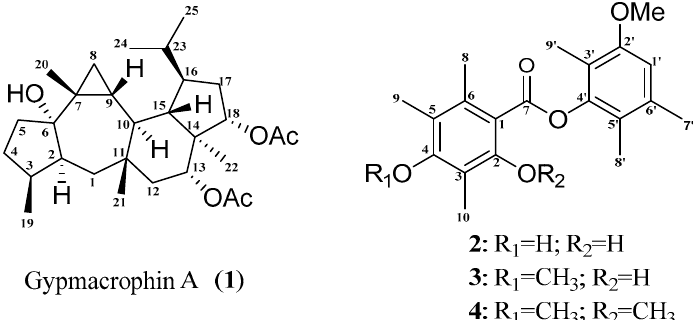
Figure 1. Structure of gypmacrophin A ( 1 ) and brialmontins I-III ( 2 – 4 ).